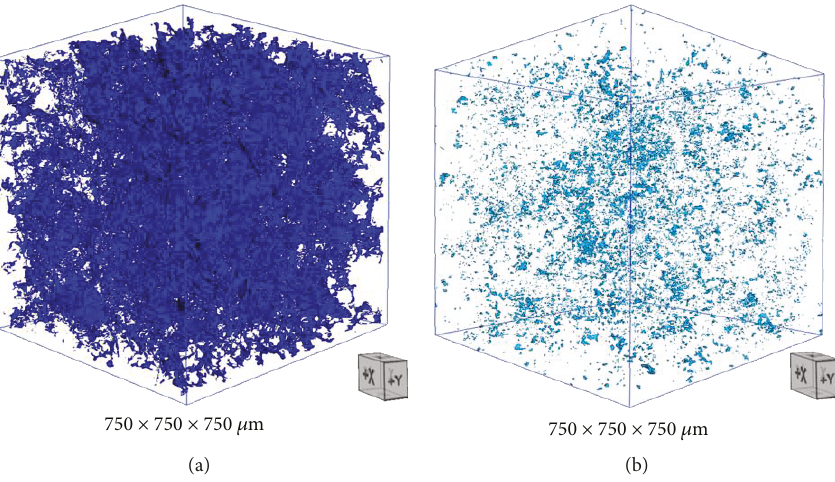
Figure 12: 3D distribution of irreducible water: (a) pore system; (b) throat